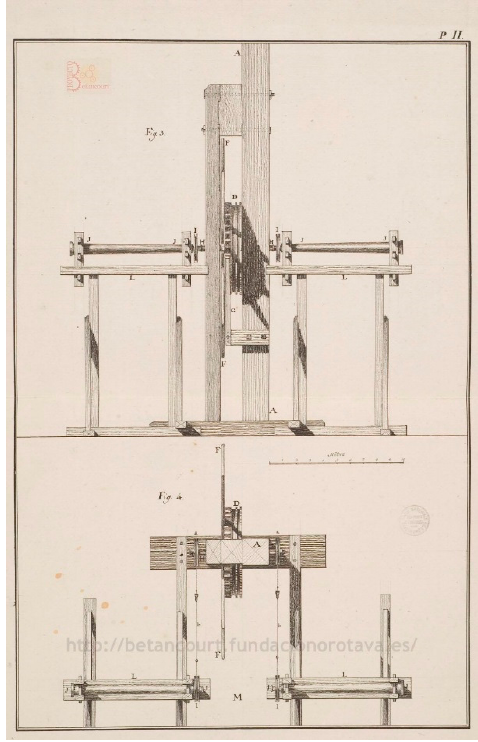
Figure 2. Longitudinal (top) and cross (bottom) sections of the optical telegraph by Agustín de Betancourt and Abraham Louis Breguet [18] (Courtesy of Fundación Canaria Orotava de Historia de la Ciencia).